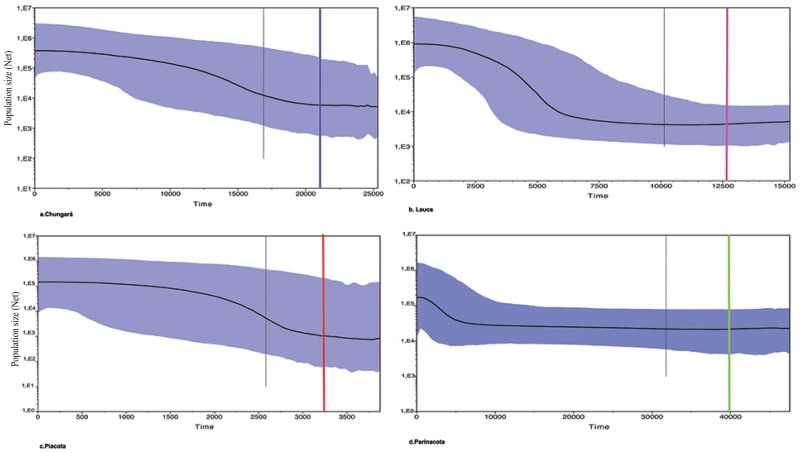
Historical demographic trends of the effective population size (Ne) constructed using a Bayesian skyline plot approach based on control region haplotypes of groups of Orestias (a. Chungará, b. Lauca, c. Piacota, d. Parinacota).The y-axis is the product of effective population size (Ne) and generation length in a log scale (Population size (Net)) while the x-axis is the time before present (years). The median estimate (black solid line) and 95% highest probability density (HPD) limits are shown (in purple). The color lines represent the time of the most recent ancestor (TRCMA) in the Orestias population. The thin dashed line represents time for the expansion in the species.